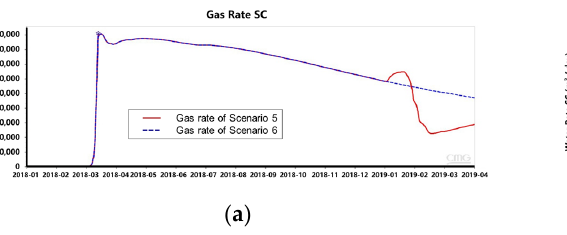
Figure 11. Comparison of gas rate and water rates of different scenarios. ( a ) Gas rate. ( b ) Water rate.